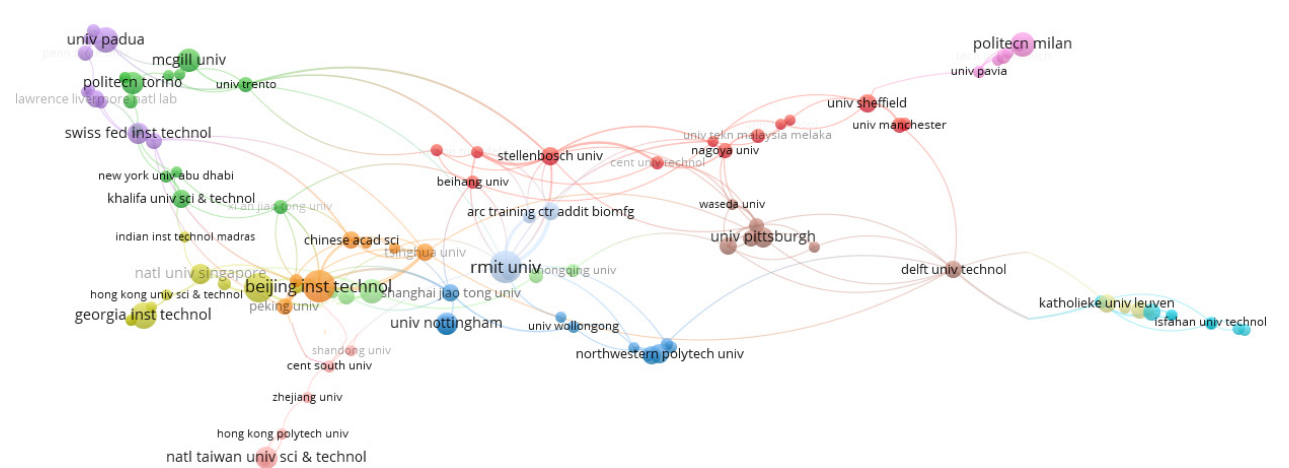
Figure 16. Visualization of network for affiliations on “additive manufacturing on lattice structure” research (data retrieved from WoS database on 20 June 2022 and visualized with VOS Viewer).